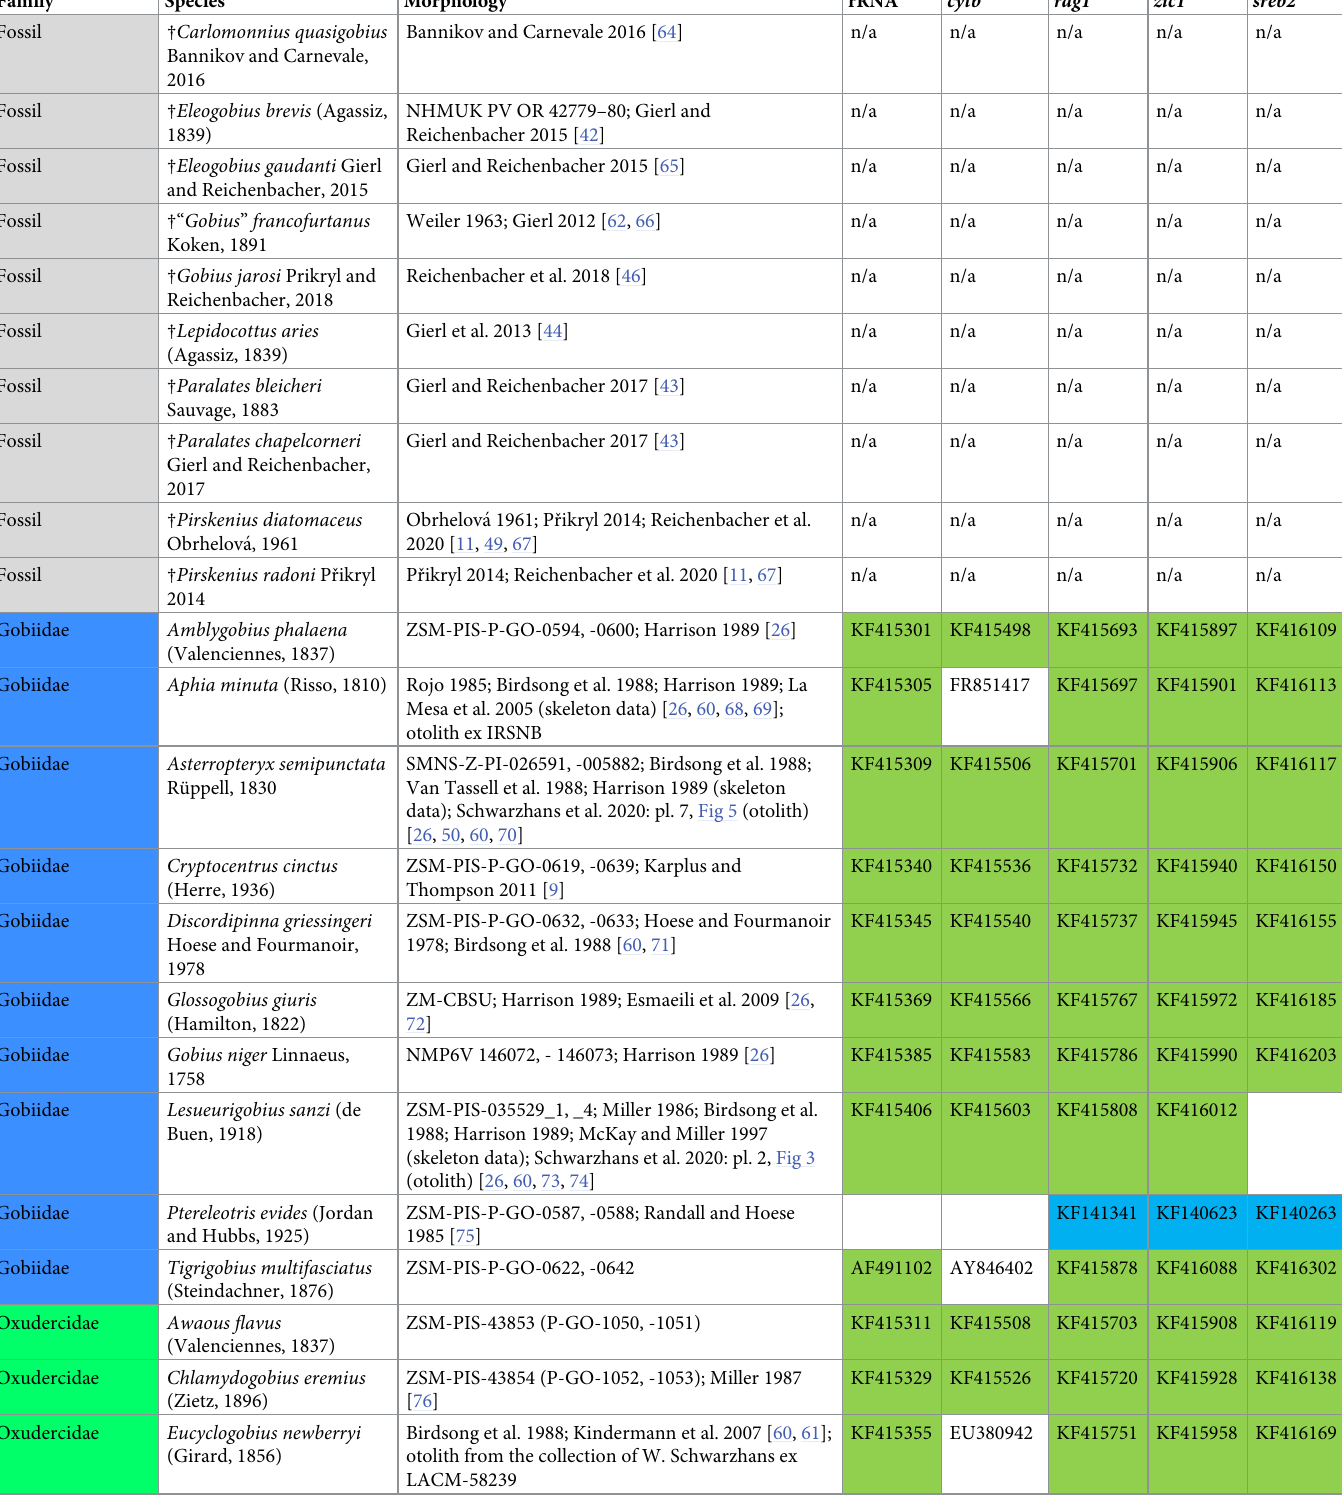
Table 1. Species and specimens used in this study. Birdsong et al. [60], Hoese and Gill [28] and Gill and Mooi [15] are used for morphology of many or all species. Col- our codes for molecular data: Agorreta et al. [12] = green; Near et al. [63] = blue; Thacker et al. [10] = red; for not color-coded cells see entries in Genbank via given acces- sion